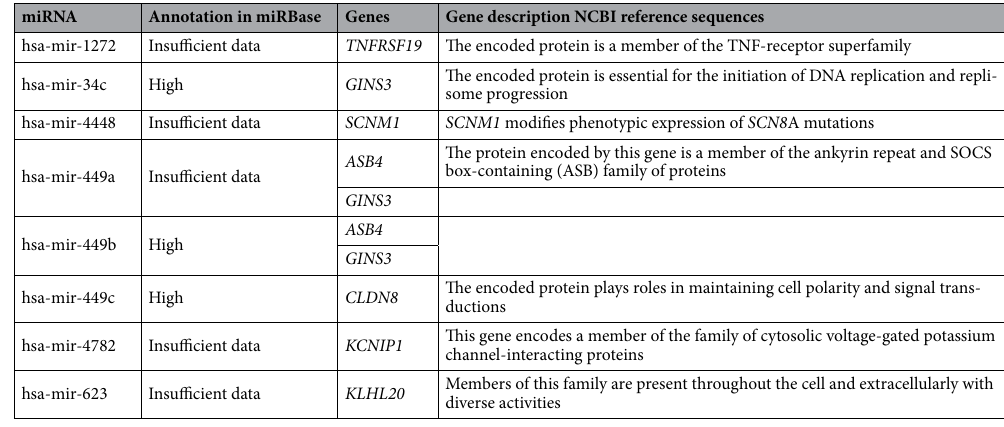
Table 3. Candidate miRNA-target gene pairs associated with AESD. The enrichment of the pairwise association signals of miRNAs and their target genes was evaluated. The significance threshold of p - Gene and p - miRNA was α =